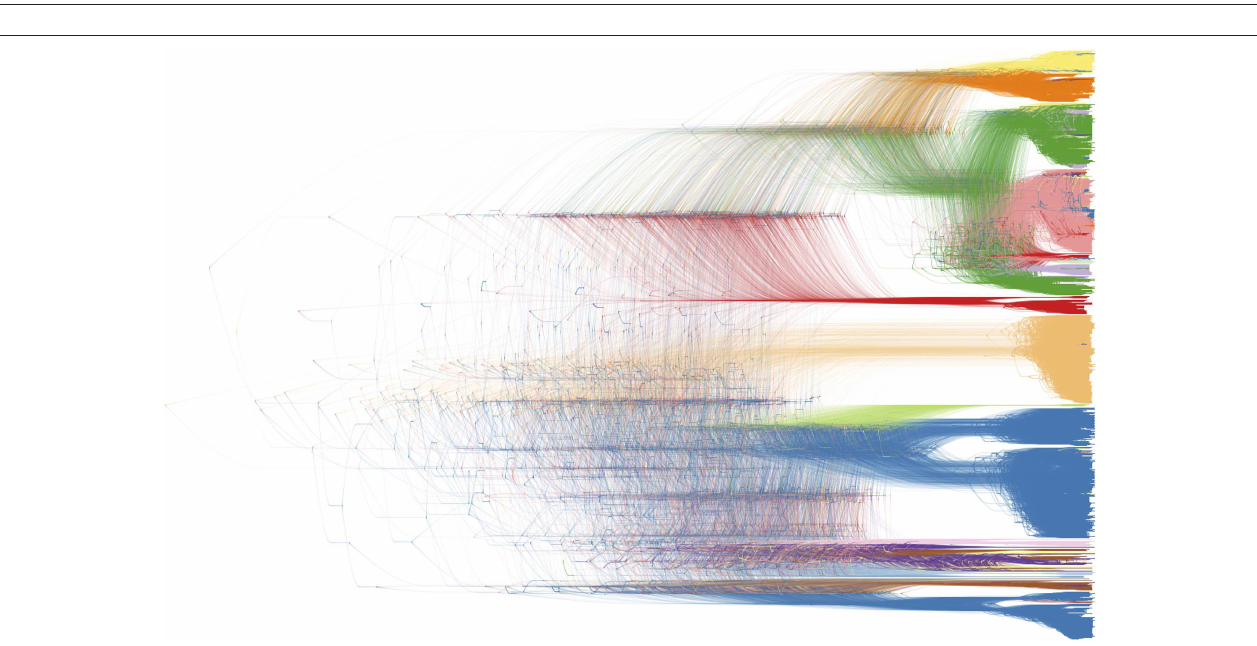
FIGURE 9 | Tanglegrams are typically shown in a side-by-side manner, in order to easily and visually identify differences in clustering between two or more phylogenetic trees, for example when inferred from different influenza proteins (PB1, PB2, PA, HA, NP, NA, M1, and NS1). Such a series of trees can also be visualized in a circle facing inwards with a particular isolate highlighted in all plotted phylogenies (left figure) , or with all isolates interconnected between all proteins (right figure) .